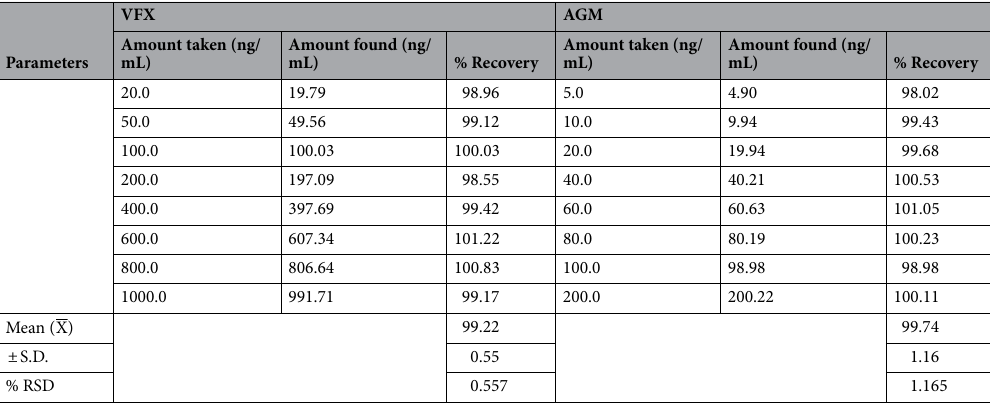
Table 3. Accuracy results of the proposed method for the determination of VFX and AGM in pure forms. N.B. Mean of three separate determinations.